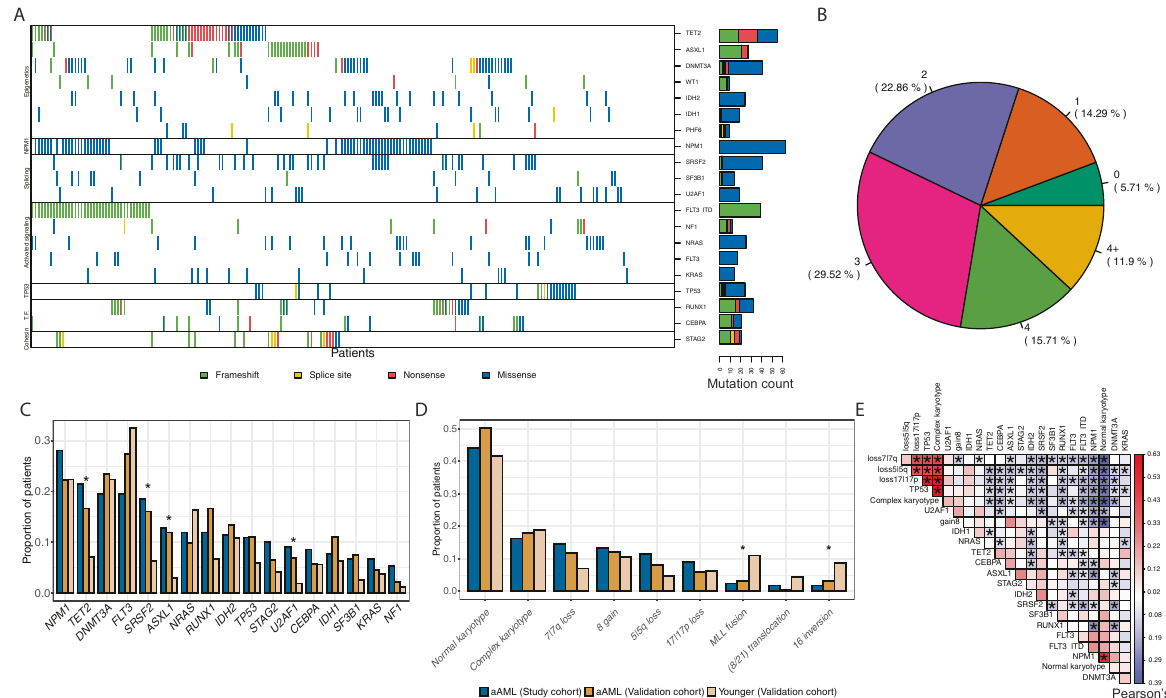
Fig. 1 Somatic events landscape of the aged AML study cohort. A Co-mutation map for the cohort ( n = 210). Each column is a gene and each row is a patient. Mutations of oncogenic or likely oncogenic signi fi cance were summarized by gene, with the exception of the FLT3-ITD mutation that was independently plotted. A cell is colored according to the type of mutation if a somatic mutation in the corresponding gene was found in the corresponding patient. Every gene that is mutated in at least 5% of the cohort ( n = 10) is included. Colors: green is frameshift, yellow is splice site, red is nonsense, and blue is missense. Horizontal stacked bar graph represents the count summary for all mutation types per gene. B Percent of patients with oncogenic or likely oncogenic somatic mutations in the study cohort. C Bar plot of recurrent somatic mutations ’ frequencies in the study cohort (blue), aAML patients in validation cohort I (brown), and AML patients younger than 60 in validation cohort I (tan). * is adjusted p -value < 0.05 from a Fisher ’ s exact test. D Bar plot of recurrent cytogenetic event frequencies in the study cohort (blue), aAML patients in validation cohort I (brown), and AML patients younger than 60 in validation cohort I (tan). * is adjusted p -value < 0.05 from a Fisher exact test. E Co-occurrence plot of the most common somatic events in the aAML study cohort. Mutations were summarized by gene, with the exception of FLT3-ITD that was independently plotted, and each cytogenetic event was summarized at the chromosomal level, with the exception of normal and complex karyotypes. Every event that is present in >5% of the cohort with available data (i.e., n > 9) is represented. Each cell represents the correlation between two events as measured by Pearson ’ s R with blue corresponding to mutually exclusive and red corresponding to co-occurring events. Asterisks indicate statistical signi fi cance (DISCOVER FDR < 0.05, see “ Methods ” for details). Pearson ’ s r = Pearson correlation coef fi cient ( r